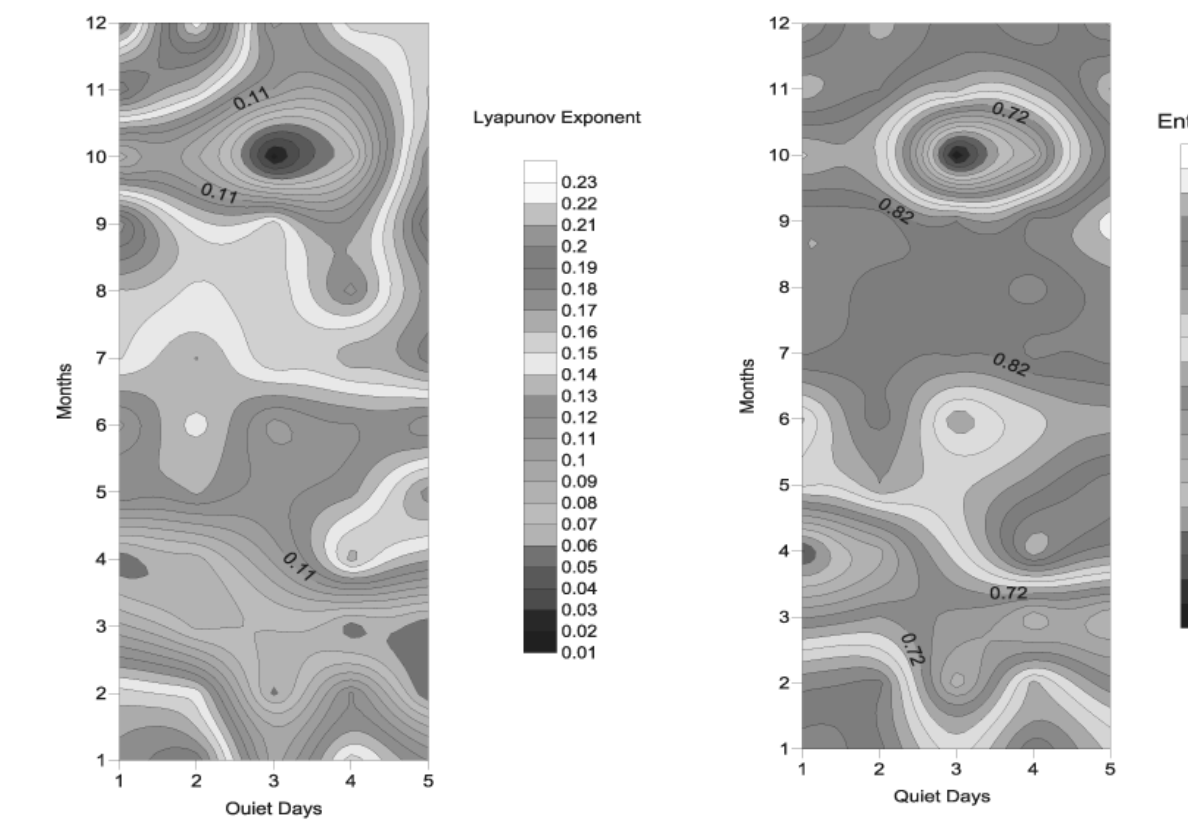
Fig. 14. Contour plot of Lyapunov exponents at Enugu station for quiet days of 2011.